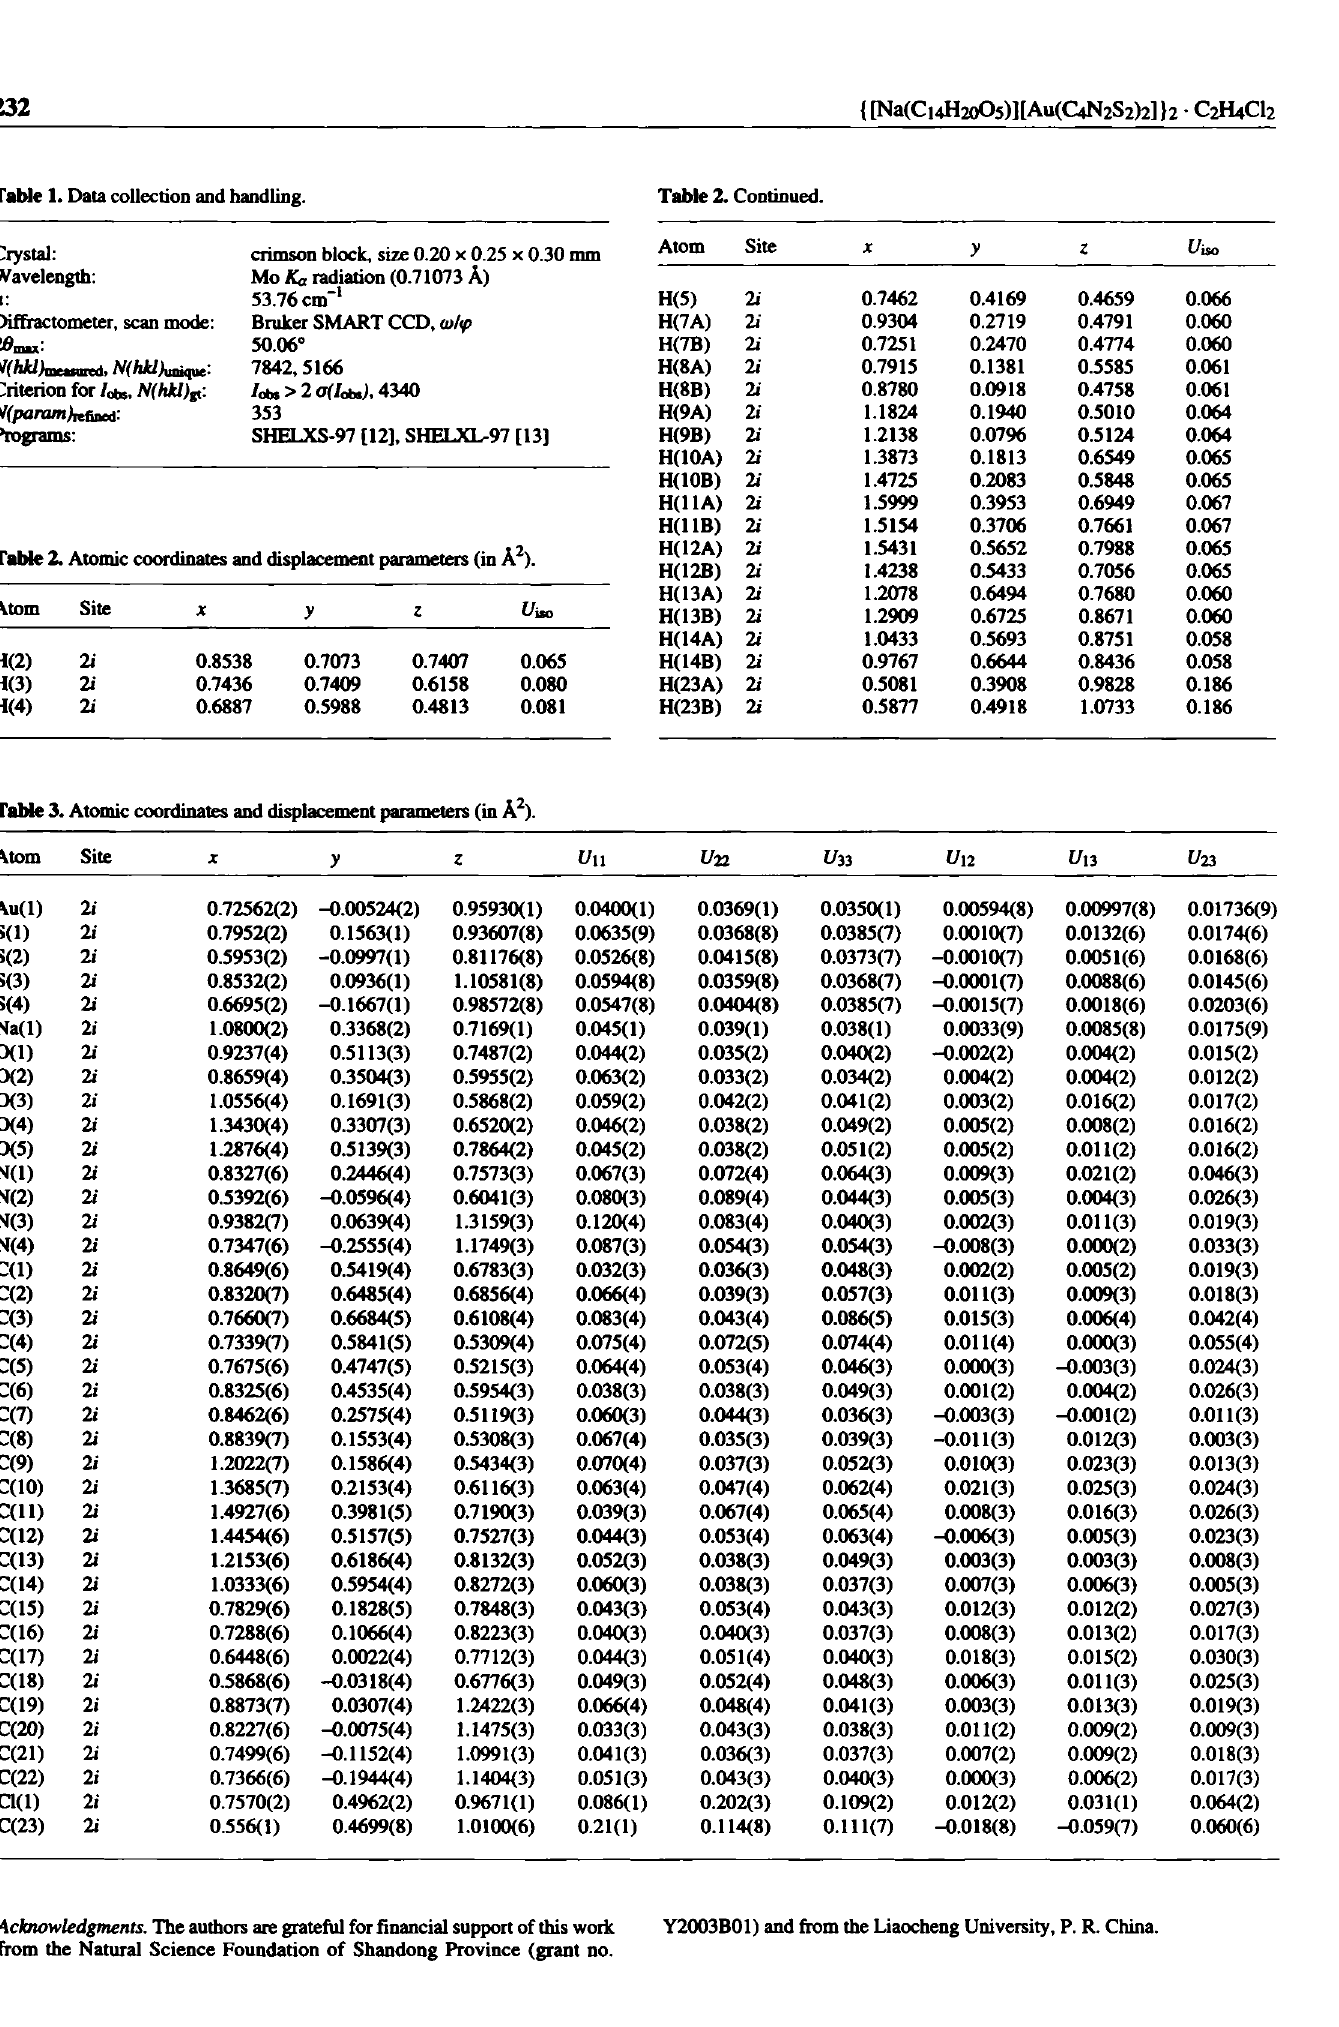
Table 2. Atomic coordinates and displacement parameters (in A 2 ).